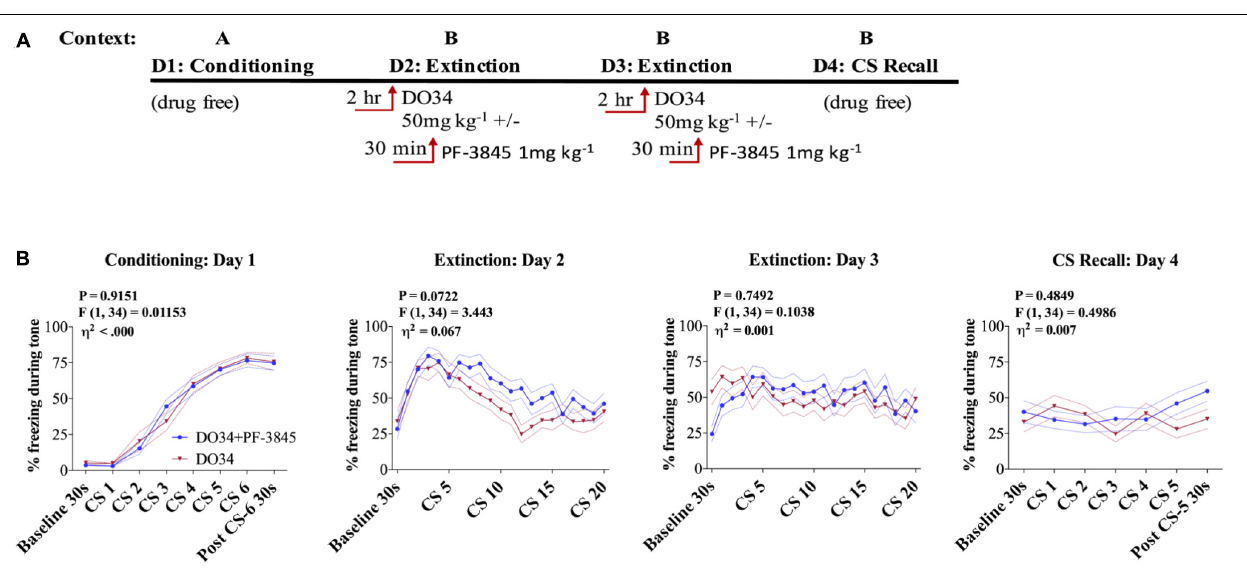
FIGURE 5 | AEA augmentation does not reverse impaired extinction after DAGL inhibition. (A) Schematic diagram of the experimental paradigm. (B) (Far left panel) % freezing by C57BL/6J male mice during acquisition of cue-conditioned fear. (Middle panels) % freezing during auditory cue by mice during extinction training days 2 and 3 when DO34 (50 mg kg − 1 ) was injected alone or in addition to PF-3845 (FAHH inhibitor 1 mg kg − 1 ) IP 2 h prior to trial. (Far right panel) % freezing during extinction recall ( n = 18 male mice per condition). F - and P -values and η 2 for main effect of drug shown in each panel. All values are presented as mean ±